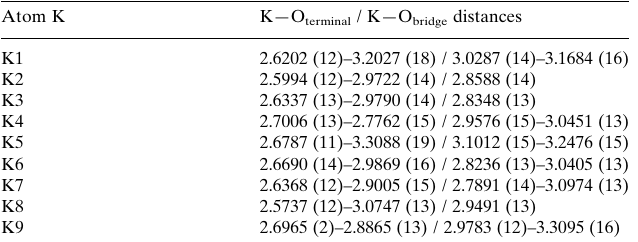
Characterization of K—O coordination spheres; the minimal and maximal K—O distances (A˚ ) for the terminal and bridging O atoms (there is only one bridging oxygen in the coordination spheres of K2, K3, and K8). Atom